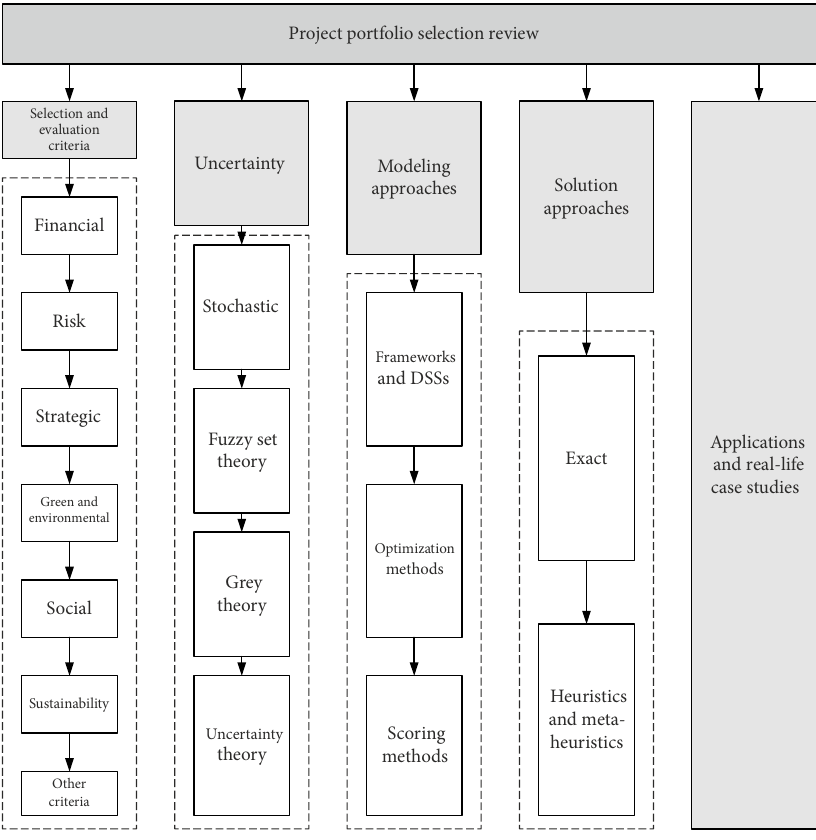
Figure 4. Taxonomy of the literature